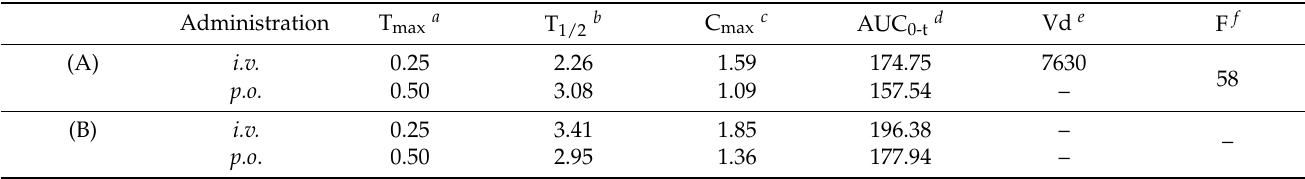
Table 3. Pharmacokinetic parameters for ALX-171 . Plasma (A) and brain (B) concentrations of ALX-171 in female BALB/c mice following intravenous ( i.v. , 3 mg/kg) and peroral ( p.o. , 5 mg/kg) administration.